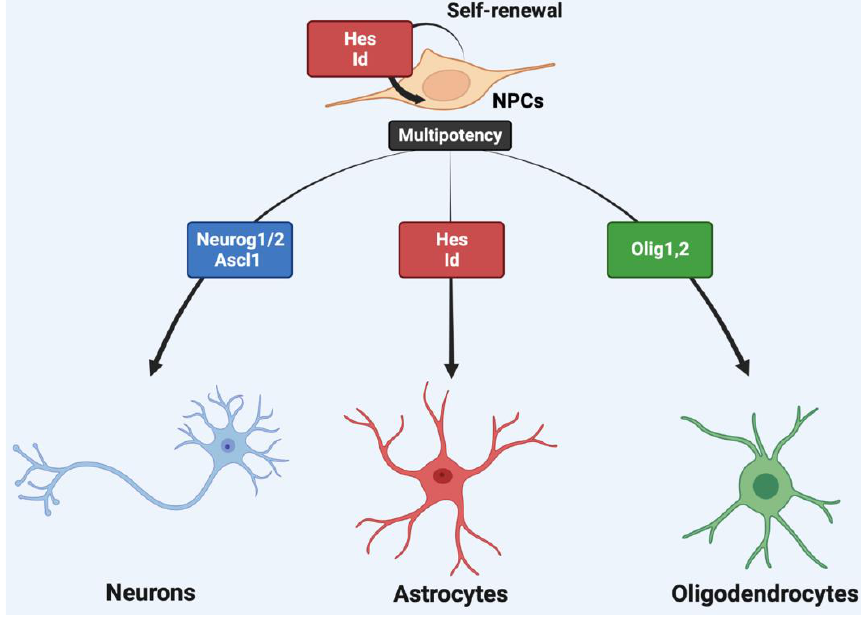
Figure 3. The choice of cell fate and self-renewal of NPCs is regulated by bHLH transcription fac- tors.